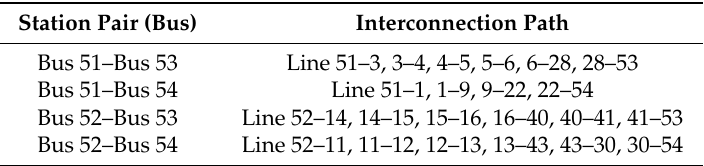
Table 3. Lines in set ψ FW